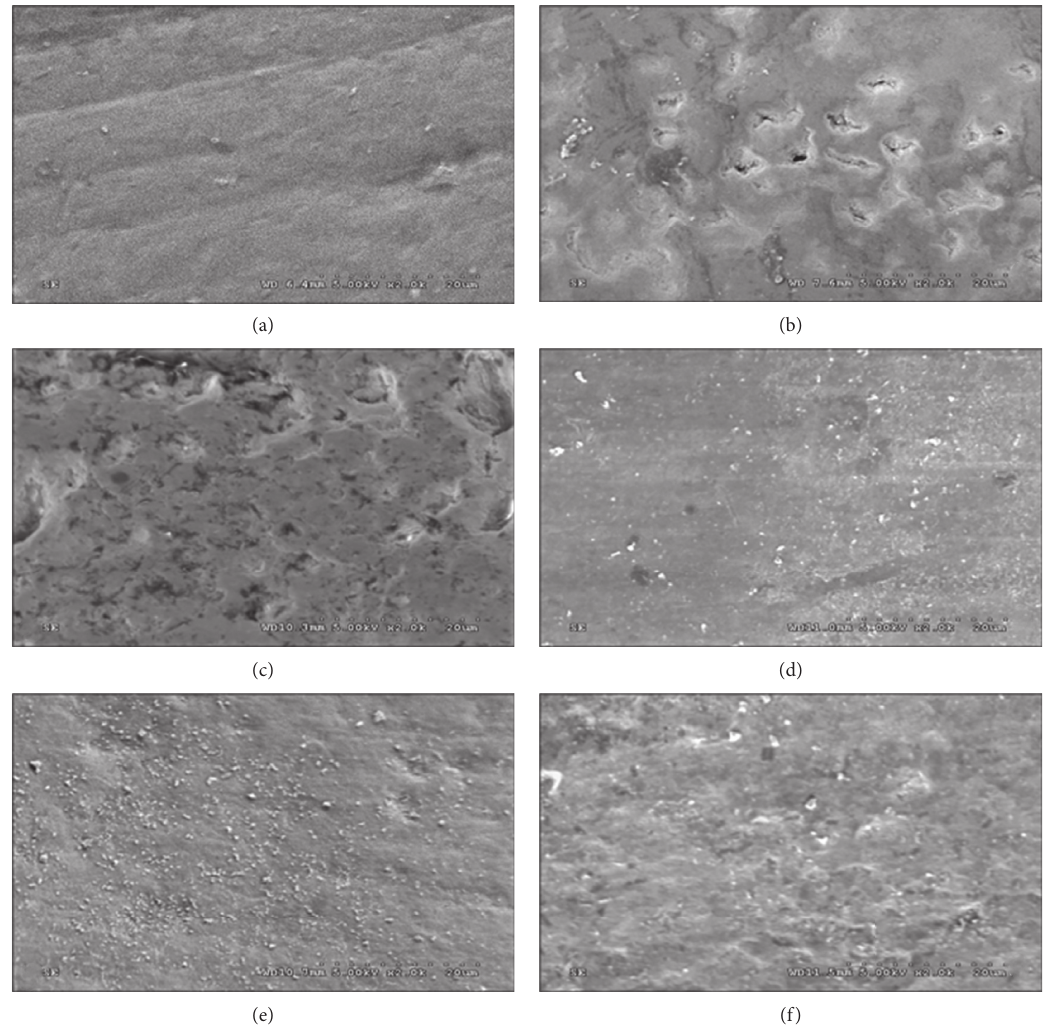
Figure 4: Scanning electron microscopy (SEM) at x2K of enamel (a), enamel after artificial formation of demineralization (b), demin- eralized enamel after application of pH-cycling without remineralization agent (c) and with remineralization agent either nano- hydroxyapatite toothpaste (d), or tricalcium phosphate toothpaste (e), or fluoride toothpaste